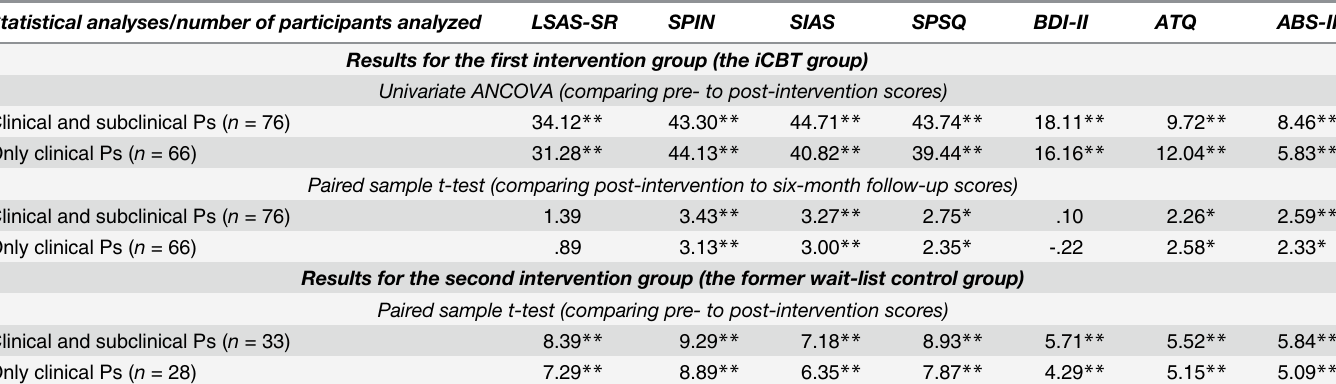
Table 3. Results of the two groups presented separately for all / for only clinical